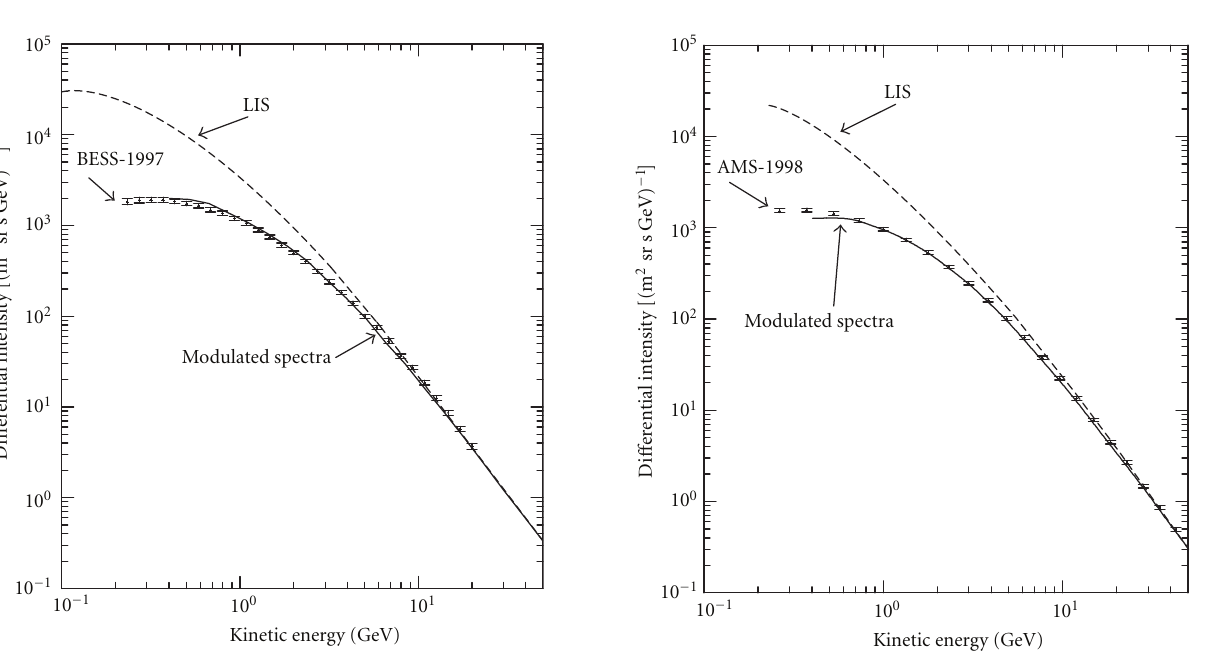
F 5: Proton differential intensity determined with the HelMod code (continuous line) compared to the experimental data of AMS- 1998; the dashed line is the LIS (see the